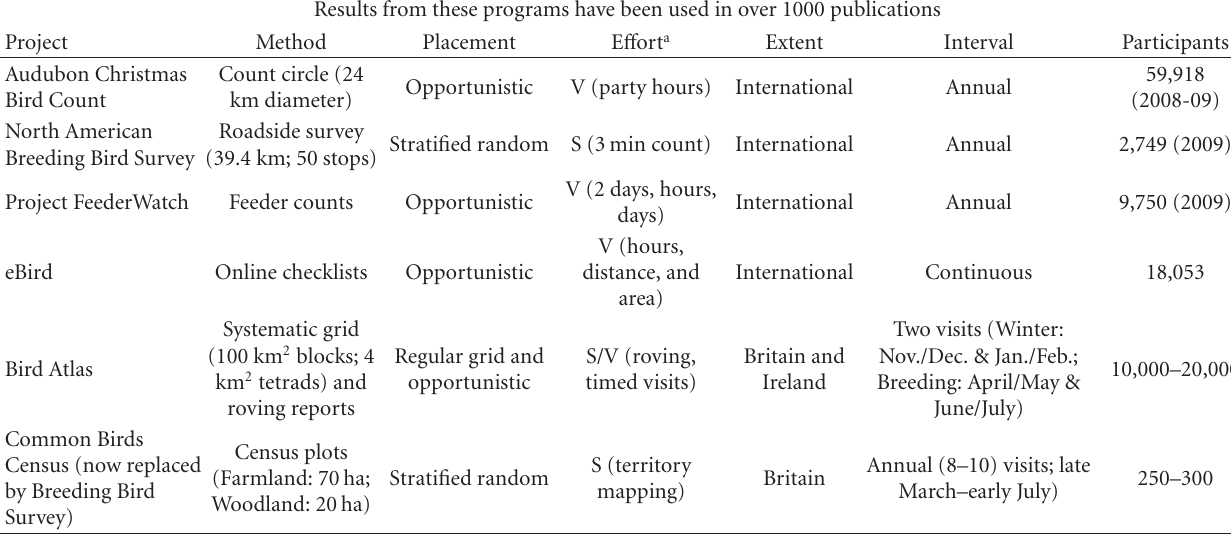
Table 5: Comparison of avian monitoring projects focused on measuring occurrence and abundance (adapted from [10]). Results from these programs have been used in over 1000 publications